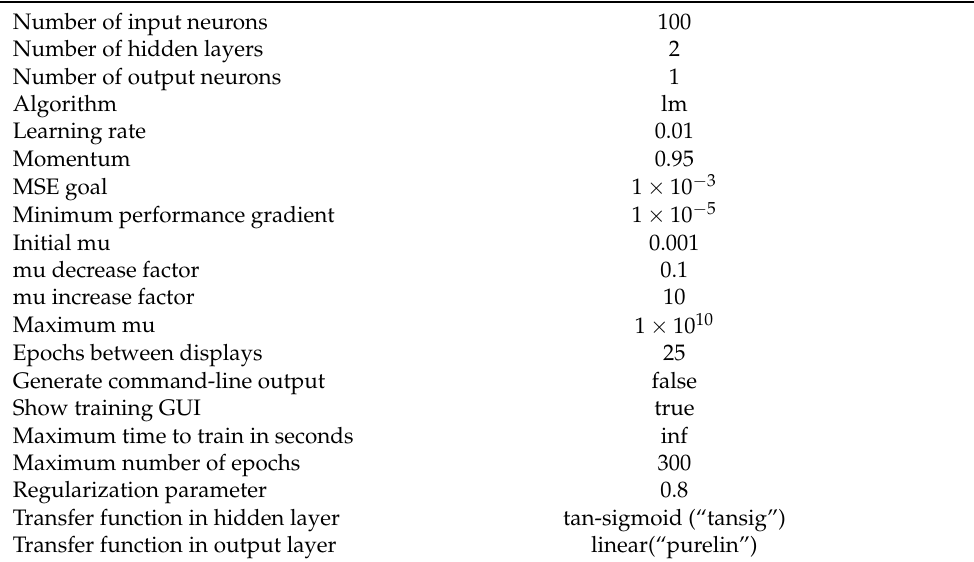
Table 1. ANN training parameters